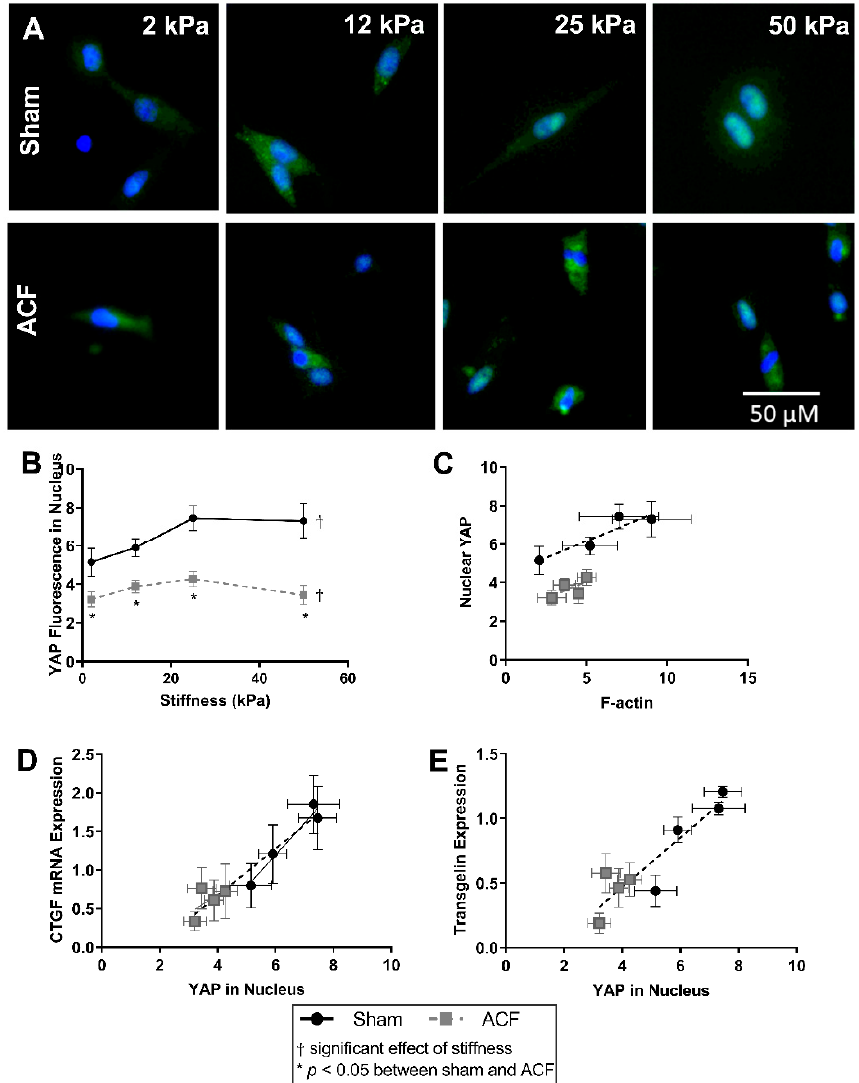
Figure 6. YAP (green) and nuclear (blue) localization using fluorescent staining ( A ) shows a stiffness dependent amount of YAP in the nucleus of Sham CFs, but not ACF. ( B ) Relative YAP fluorescence in the nucleus is lower in ACF overall. ( C ) Nuclear YAP tends to correlate with increased F-actin protein measured in sham CFs, but the amount of nuclear YAP is different between sham and ACF. ( D , E ) The amount of YAP in the nucleus correlates with downstream protein production of CTGF ( C ) and transgelin ( E ). * indicates p < 0.05 when comparing sham vs. ACF. † indicates a significant effect of substrate stiffness.